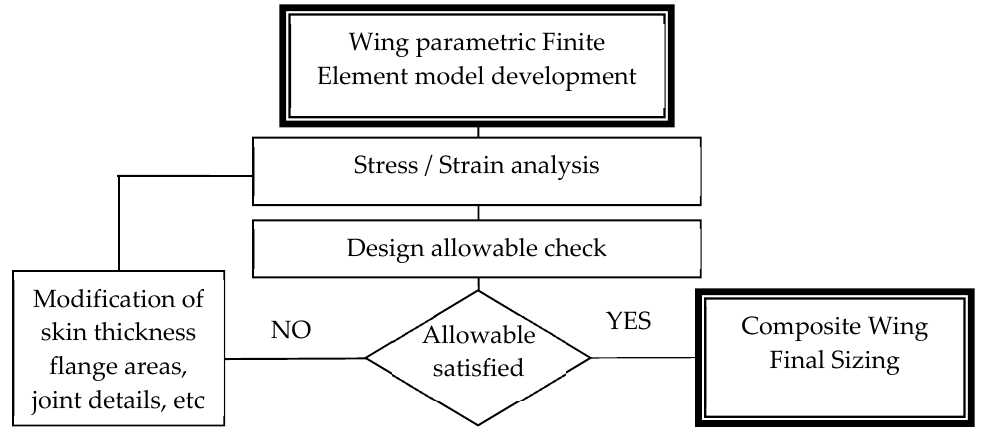
Figure 1. Flow chart of the multispar composite wing design process.